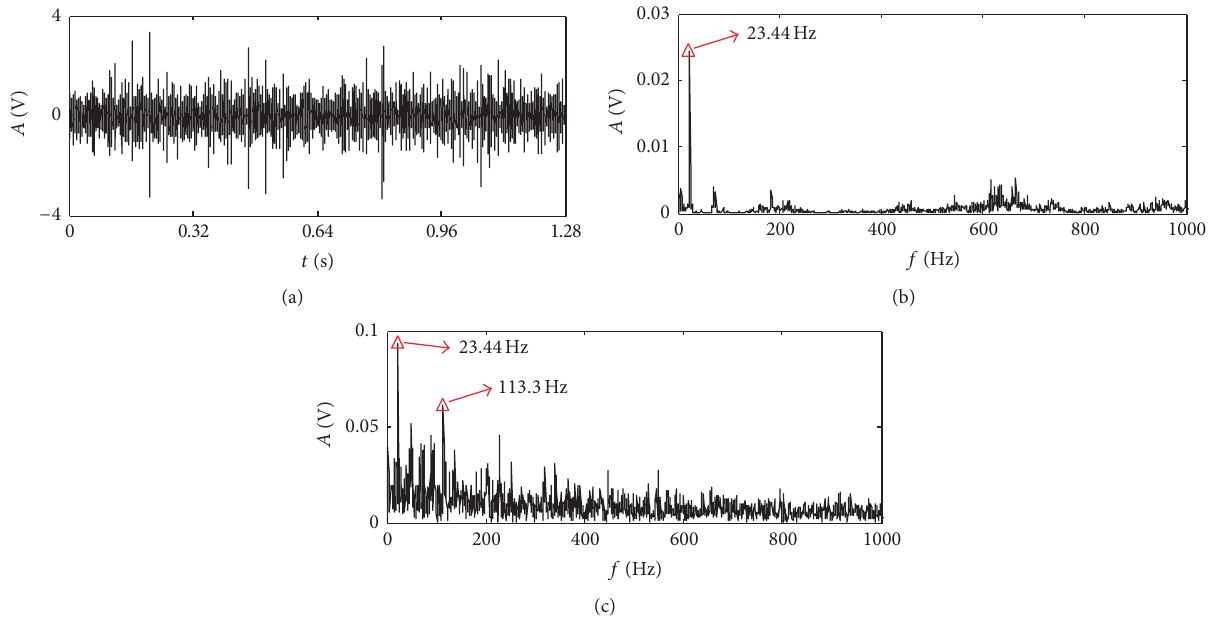
Figure 14: Vibration signal of bearing: (a) the time waveform; (b) the frequency spectrum; (c) the envelop spectrum.